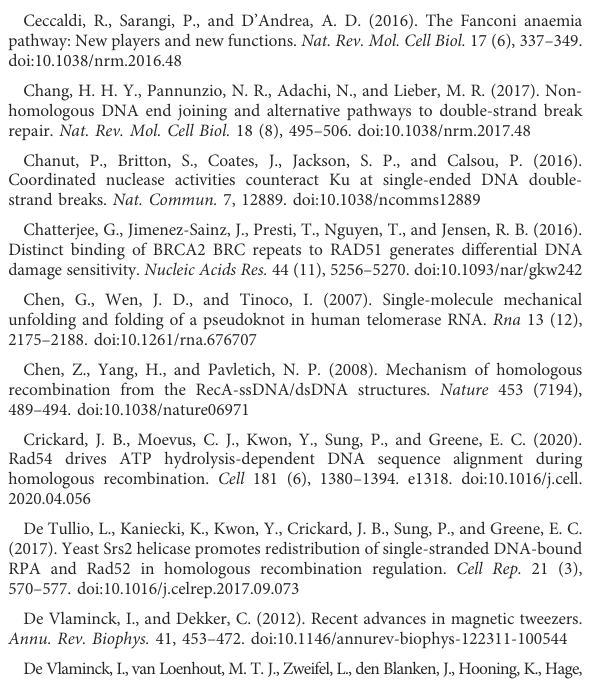
Table of Contents.